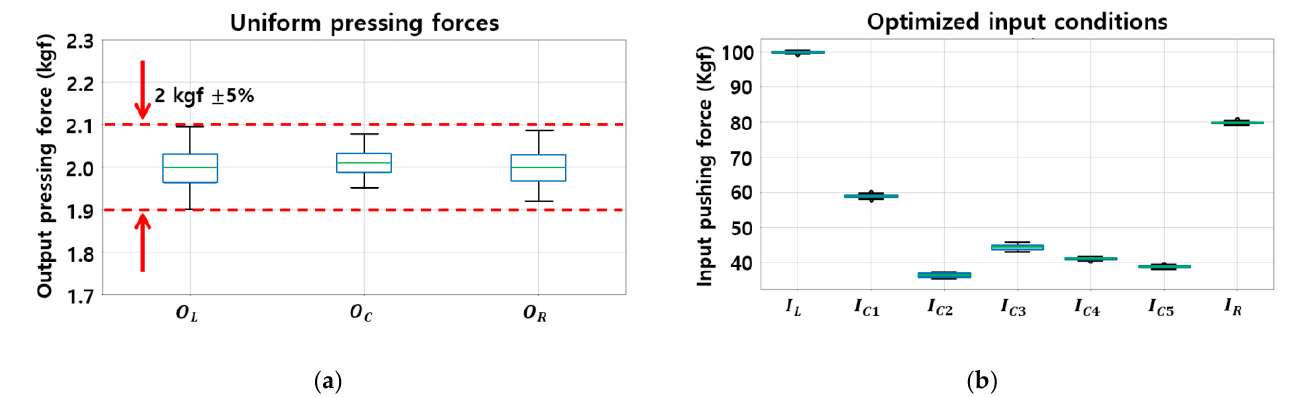
Figure 11. Random forest regression analysis result of output ( 𝑂 𝐶 ) value according to input ( 𝐼 𝐶3 ) value.